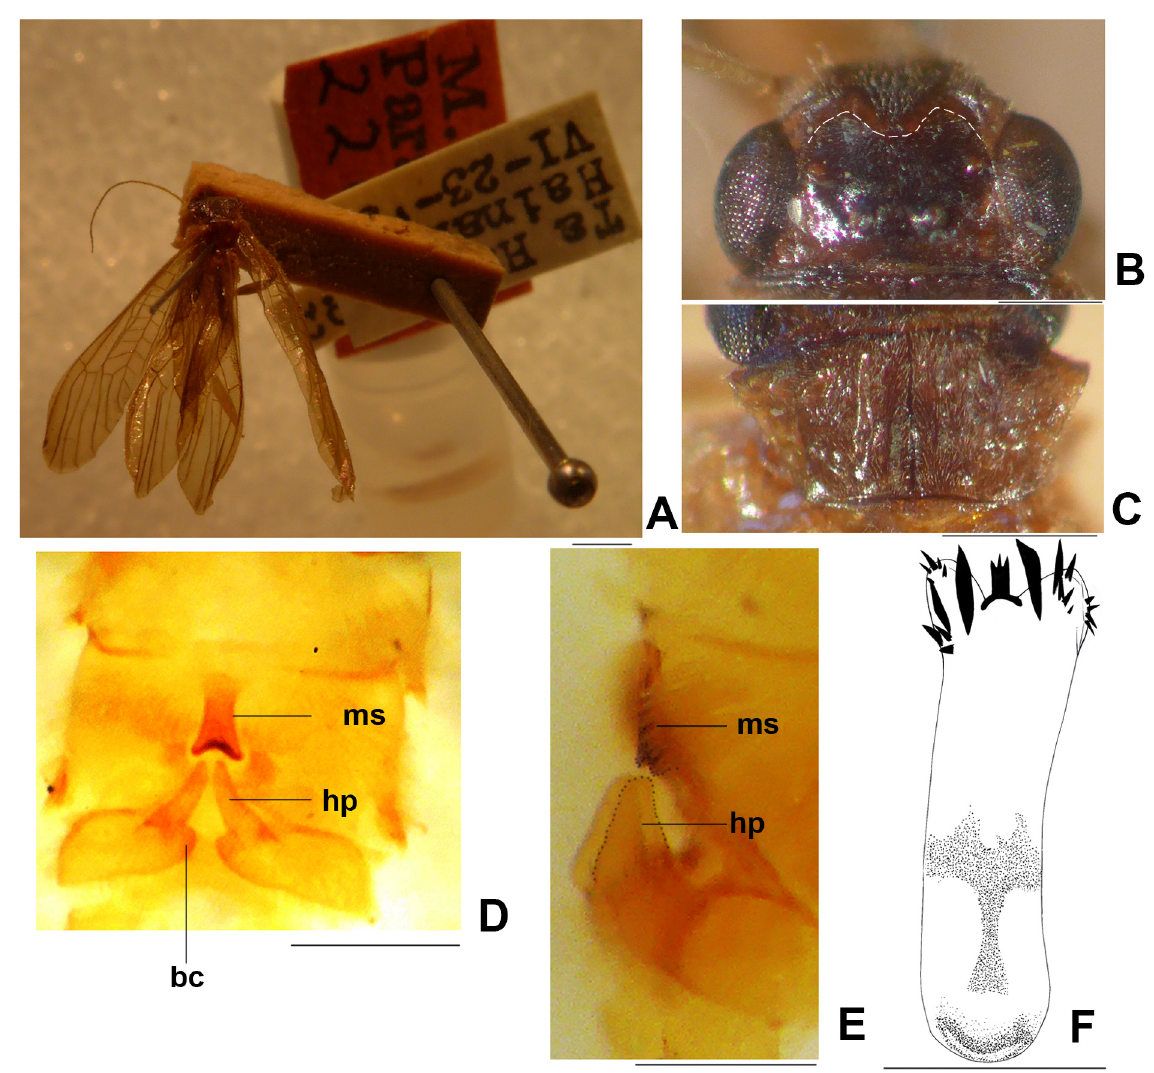
Fig. 3. Chinoperla changjiangensis sp. nov., ♂, paratype of C. nigrifrons (Banks, 1939) (MCZ). A . Adult habitus, dorsal view. B . Head, dorsal view. C . Pronotum, dorsal view. D . Cleared terminalia, dorsal view. E . Cleared terminalia, lateral view. F . Aedeagus, dorsal view. Abbreviations: see Material and methods. Scale bars: A = 1.0 mm; B–F = 0.5